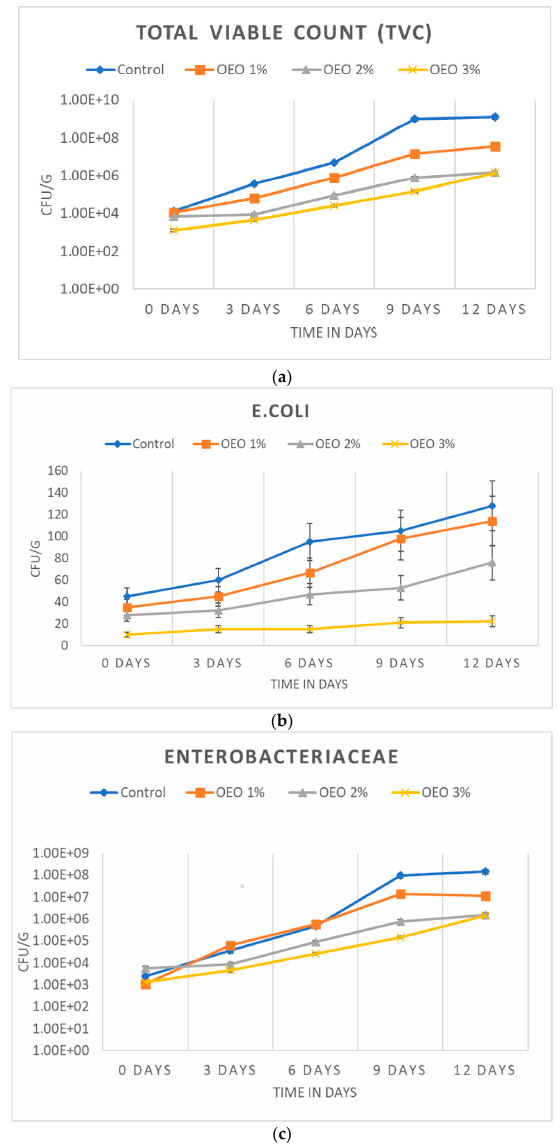
Figure 2. ( a ) Total viable counts (TVC), ( b ) E coli count, and ( c ) Enterobacteriaceae count in minced beef meat packaged with edible coating with the addition of oregano essential oil 1–3% and control sample without edible coating both at storage time 0, 3, 6, 9, and 12 days. OEO: oregano essential